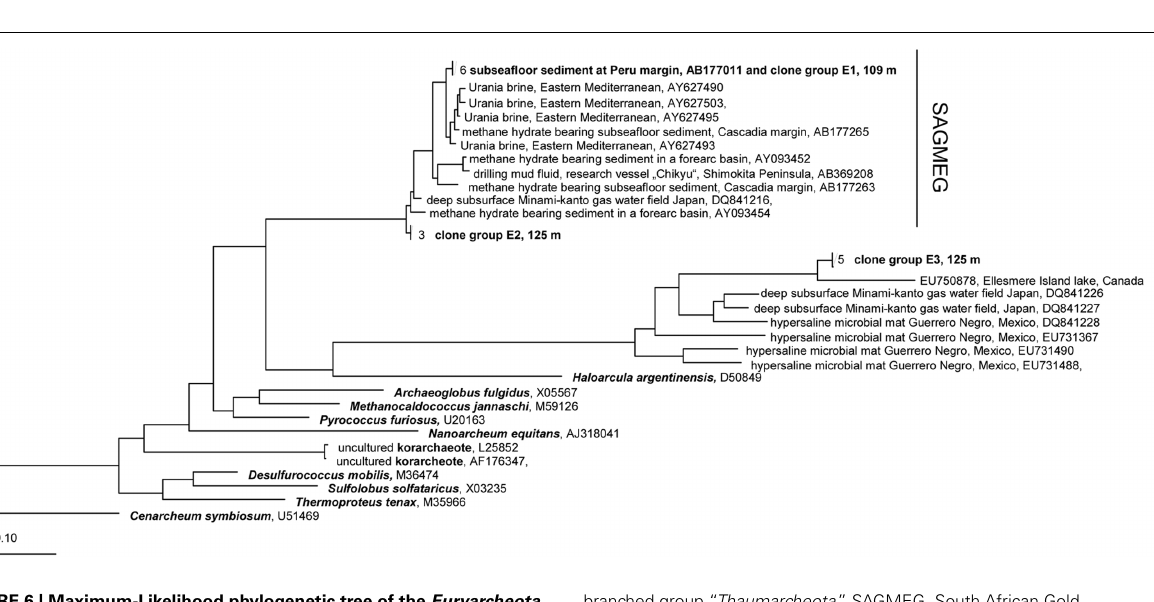
branched group “ Thaumarcheota .” SAGMEG, South African Gold Mine Group, DHVE6, Deep Sea HydrothermalVent Euryarchaeotal Group